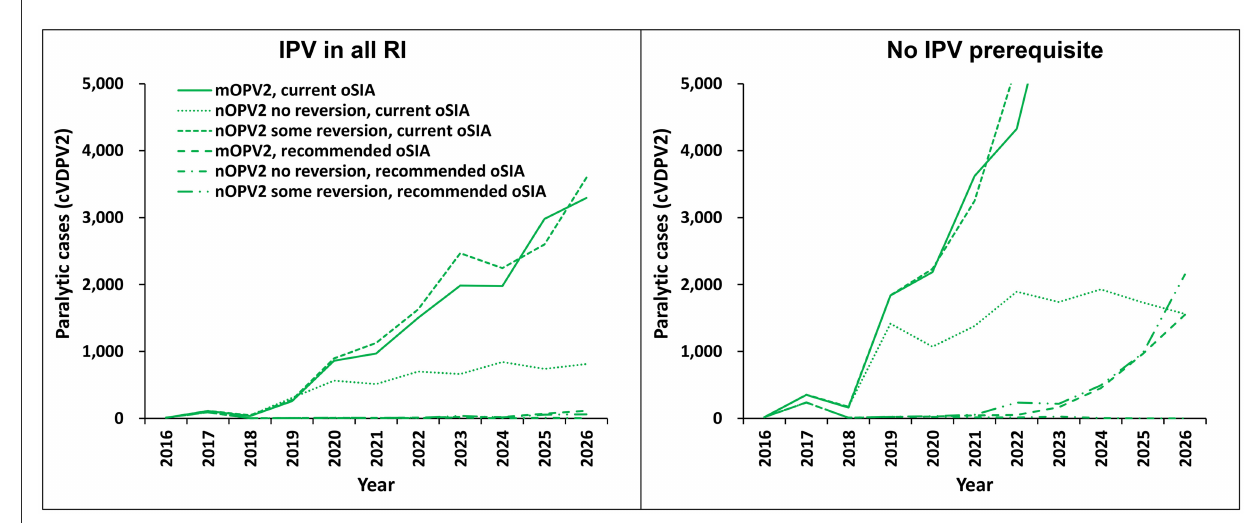
FIGURE2 Modeled expected global number of paralytic cVDPV2 cases by year for 100 stochastic iterations of the different vaccine choices and oSIA characteristics for the period 2016–2026. The figure legend shows outbreak vaccine choice and response characteristics. The panel on the left shows results for modeled scenarios in which IPV is used in RI in all countries as a prerequisite to OPV cessation. The panel on the right shows results for modeled scenarios in which there is no prerequisite for introduction of IPV into RI in countries classified as low-income or lower middle-income by the World Bank.